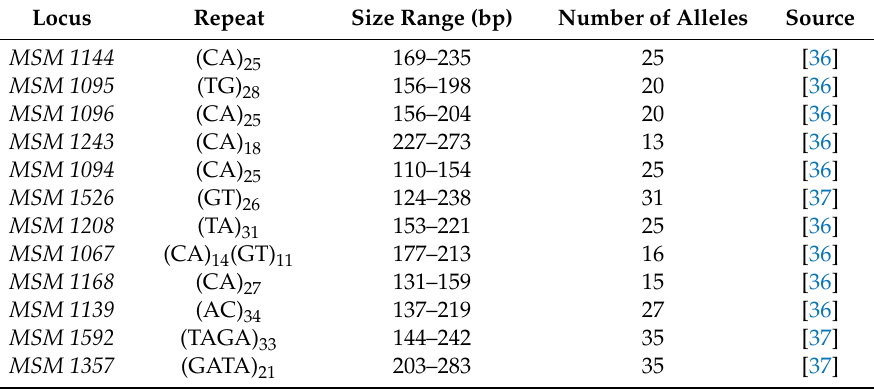
Figure 2. Atlantic coast of the United States, showing locations of rivers where striped bass were sampled. Base map: Pinterest. Table 2. Summary information for 12 microsatellite loci used to assess the population genetic structure of striped bass in this